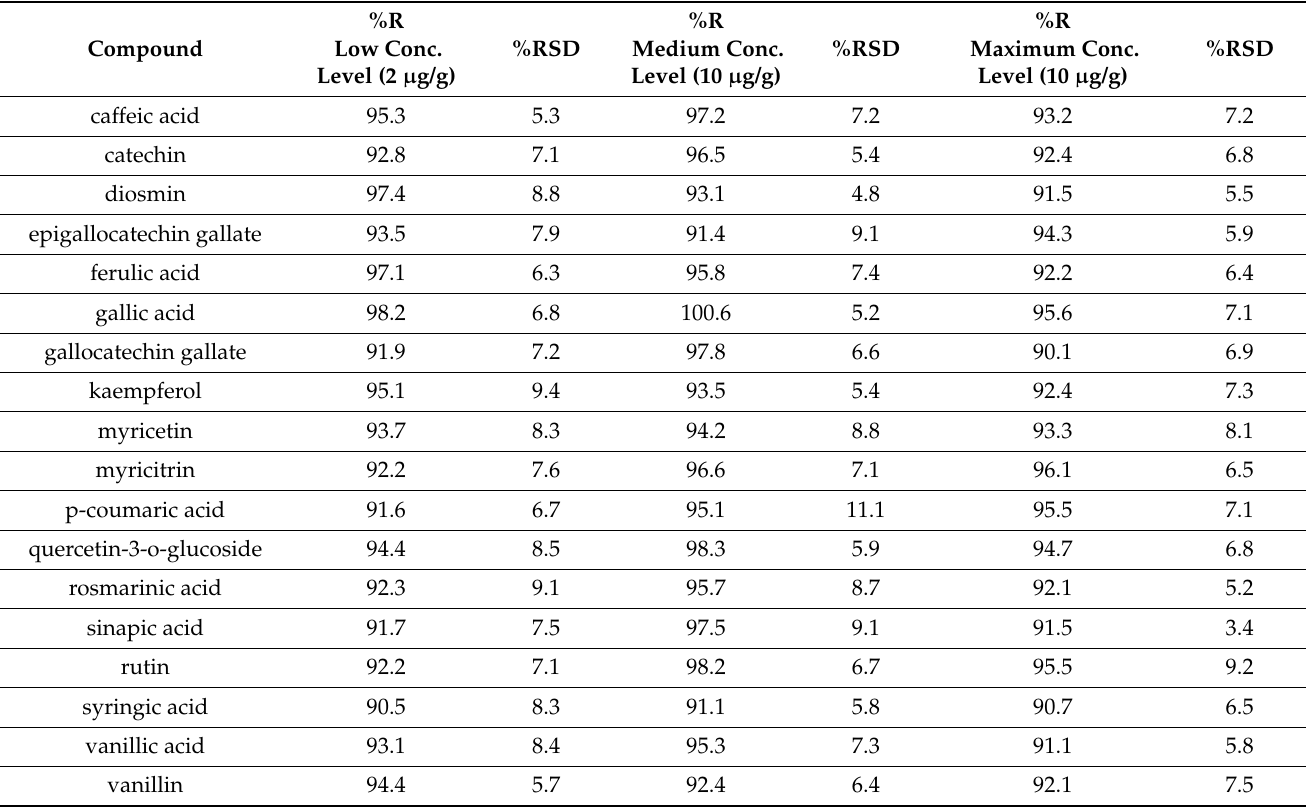
Table 3. %Recoveries (%R n = 3 × 3) for the evaluation of intermediate